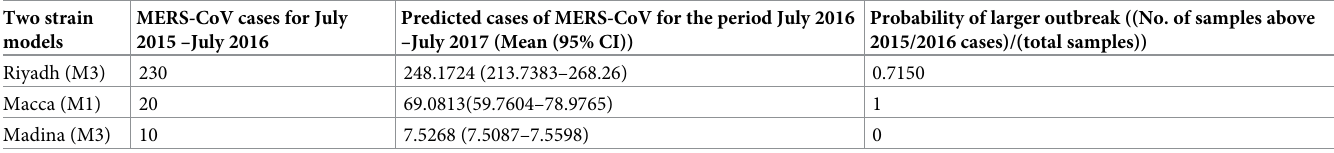
Table 3. Hindcast prediction of season total MERS-CoV cases for July 2016 to July 2017 and probability of large outbreak. Prediction based upon the best two-strain model (in terms of season totals forecast) for the three provinces of the Saudi-Arabia. Two strain